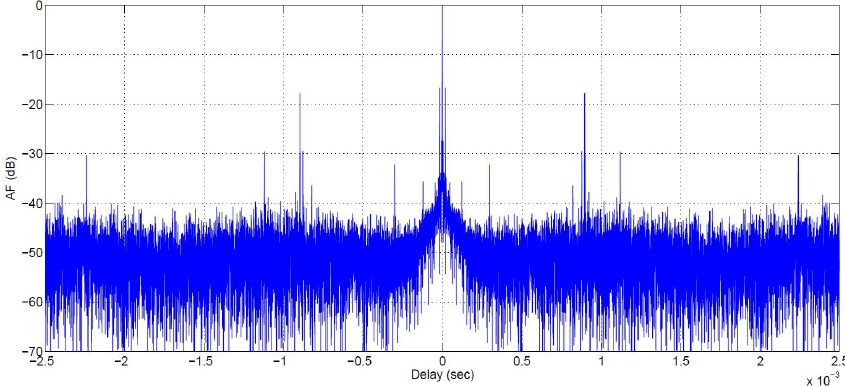
Figure 3. Zero-Doppler cut of the Ambiguity Function (AF) of a simulated Digital Video Broadcasting-Terrestrial (DVB-T) signal.